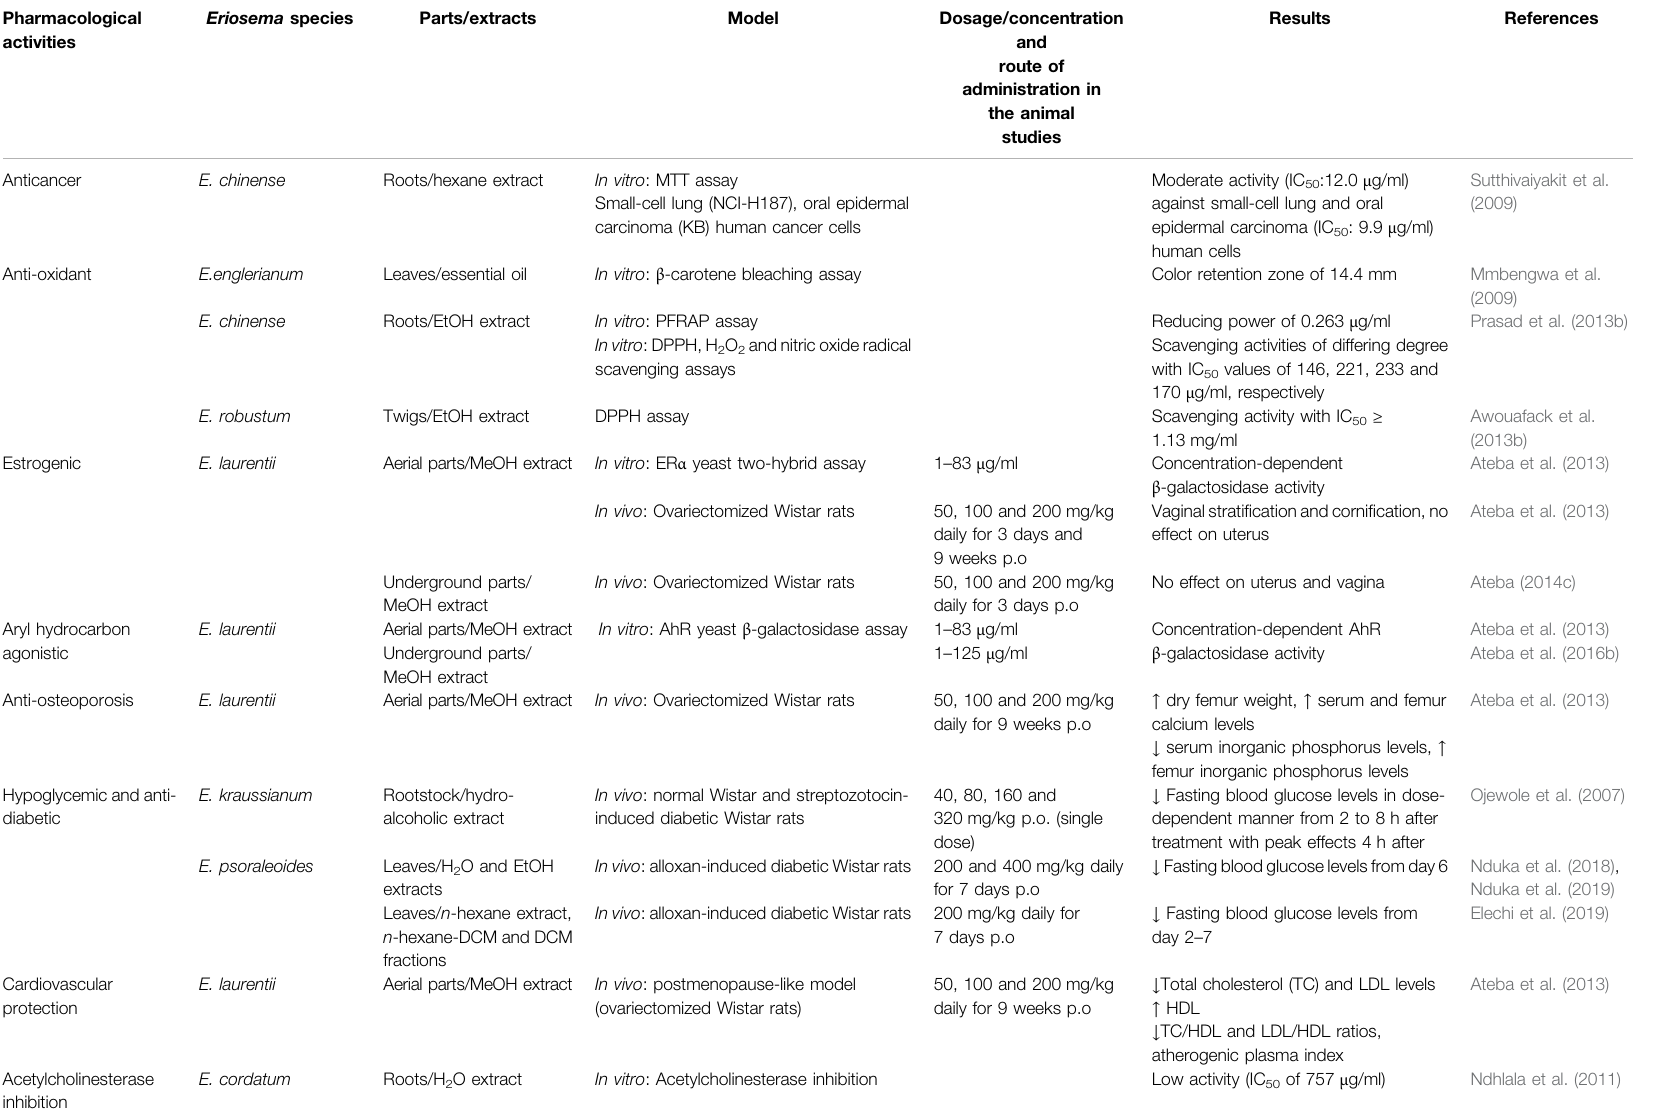
TABLE 4 | Pharmacological properties of Eriosema